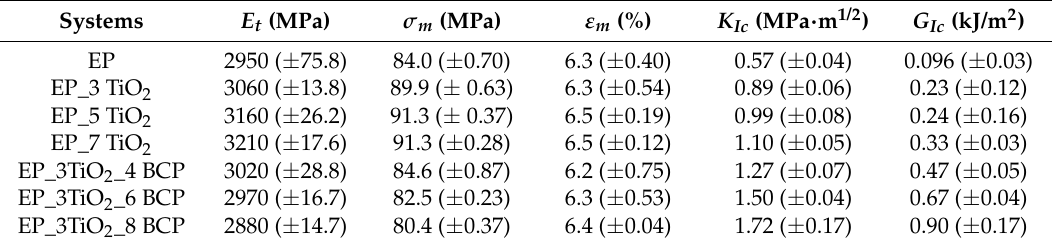
Table 4. Tensile and fracture mechanics properties of the EP_TiO 2 and EP _TiO 2 _BCP systems measured at 23 ◦